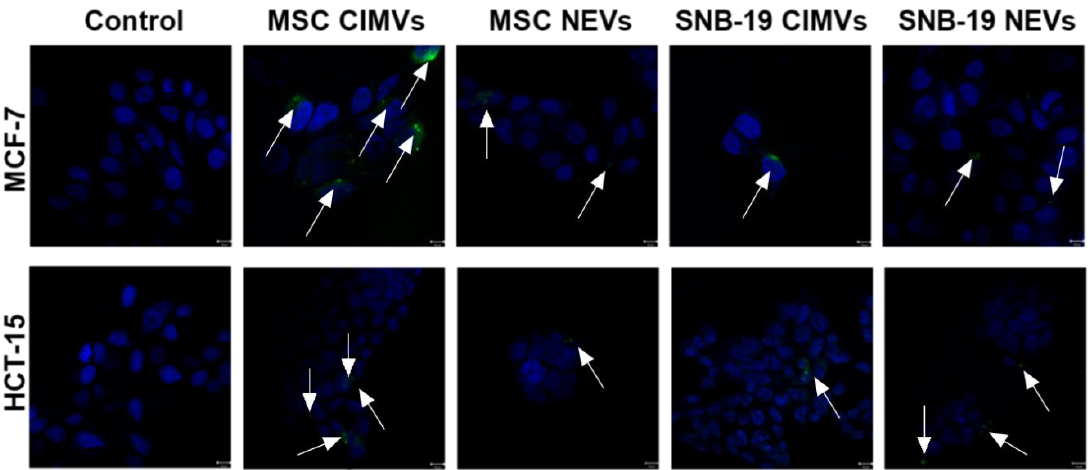
Figure 7. Confocal microscopy of HCT-15 and MCF7 tumor cells in monolayer culture. Cell nuclei were stained with DAPI (blue). CIMVs and NEVs stained with DiO membrane stain (green) are shown by arrows. Scale: 100 µm.